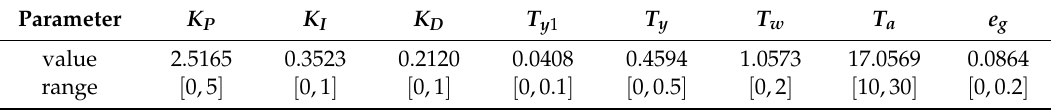
Table 6. Actual value and initial range of the parameters to be identified (load